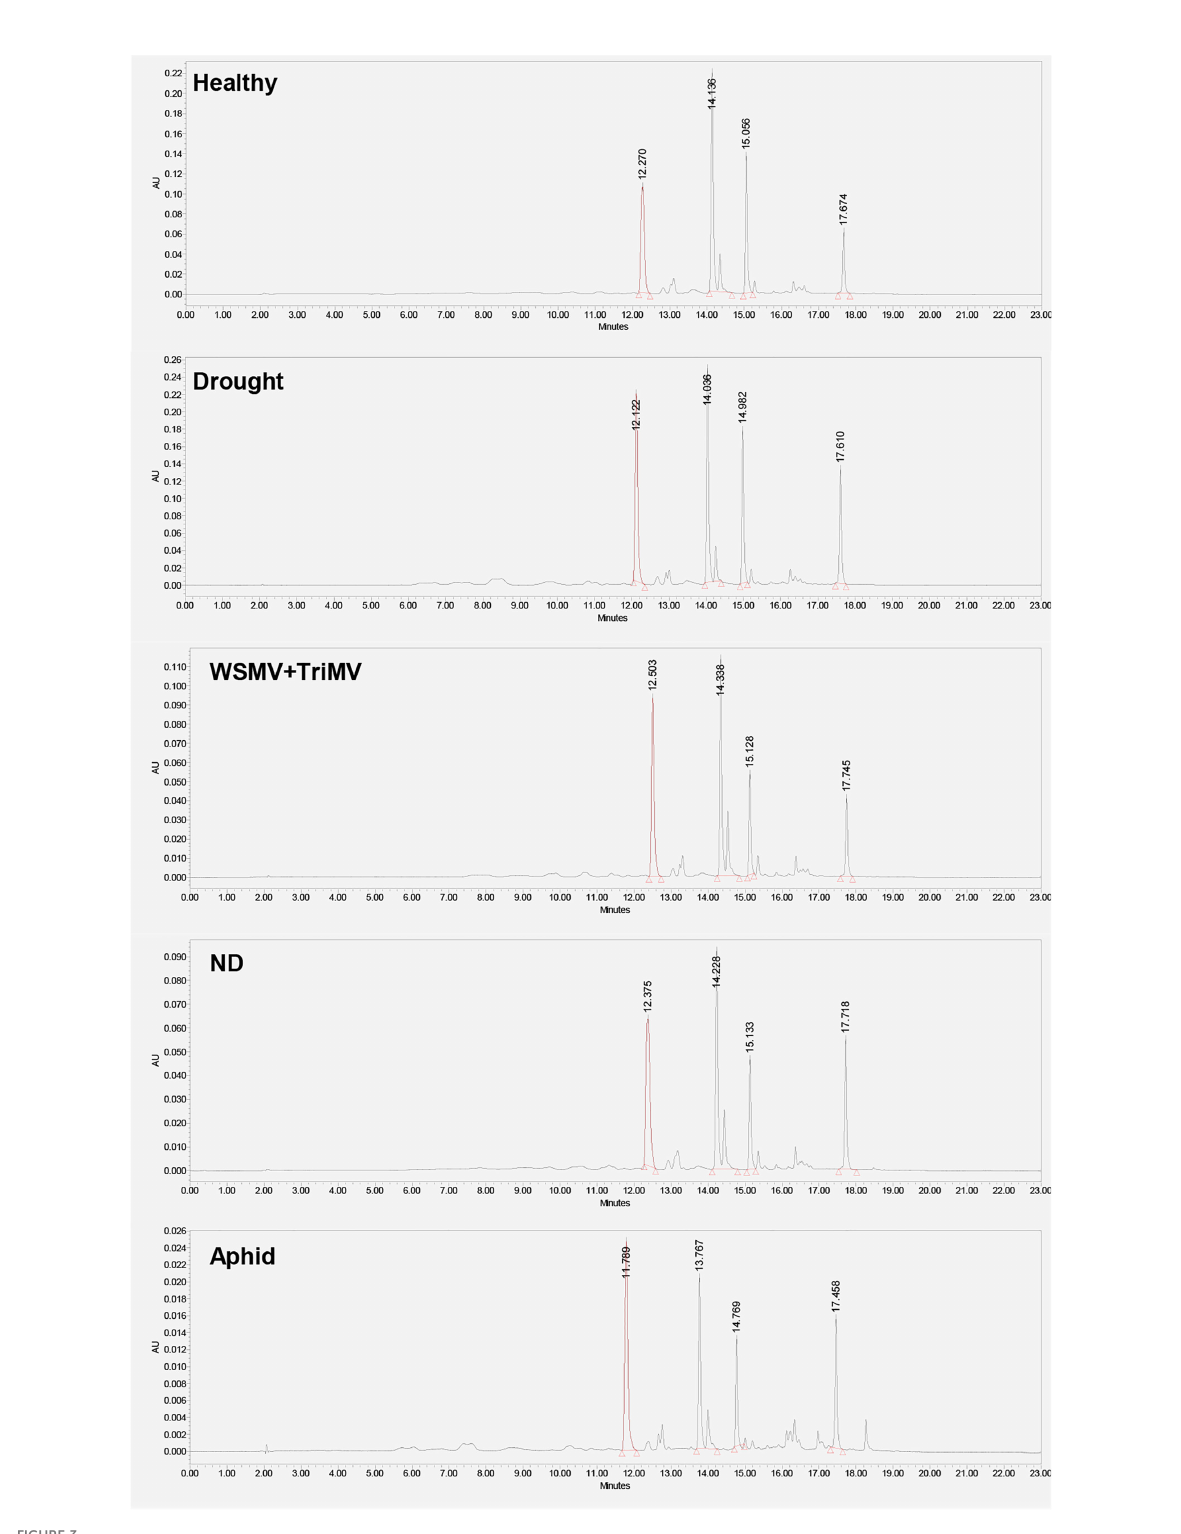
FIGURE 3 HPLC pro fi les of leaves of healthy wheat, as well as wheat exposed to drought, WSMV+TriMV infection, ND and aphid